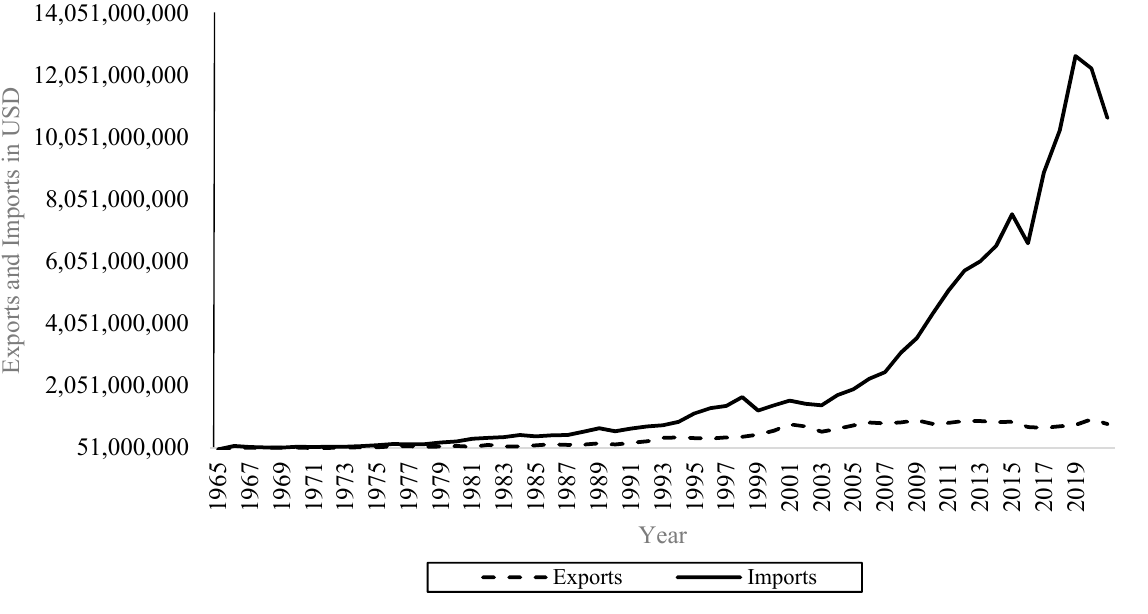
Figure 1. Exports and imports of Nepal. This figure depicts exports and imports of Nepal from 1965 to 2020. The solid and dashed lines represent exports and imports, respectively. This graph is generated using data available through the World Bank.